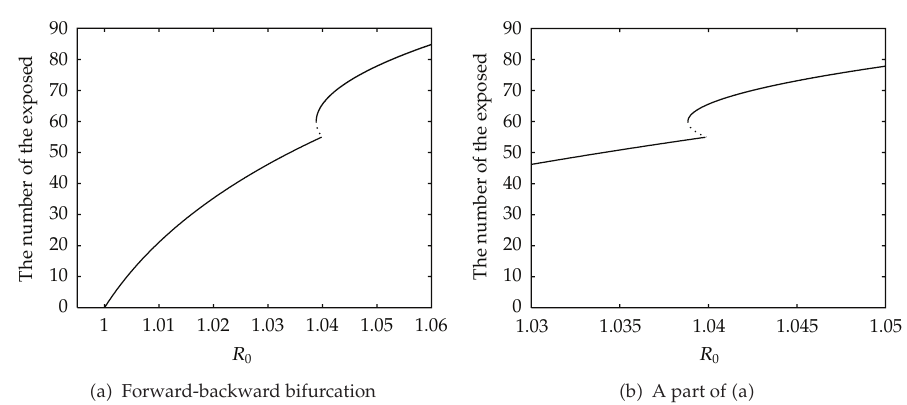
Figure 8: Forward-backward bifurcation for model (cid:2) 3.10 (cid:3) . The upper one occurs when R 0 > 1. Dotted lines represent unstable equilibria, and solid lines represent stable